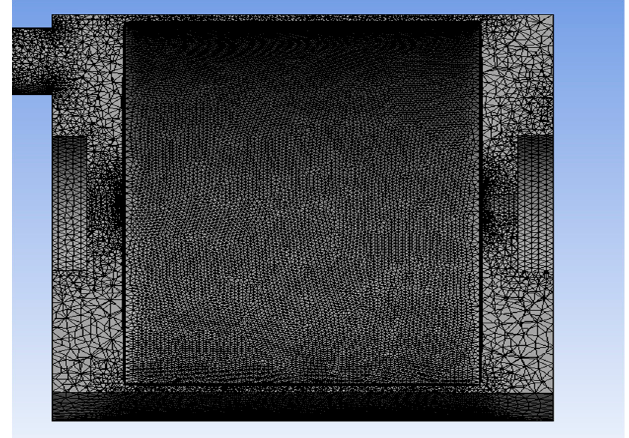
Figure 10. Computational fluid dynamics (CFD) numerical mesh.